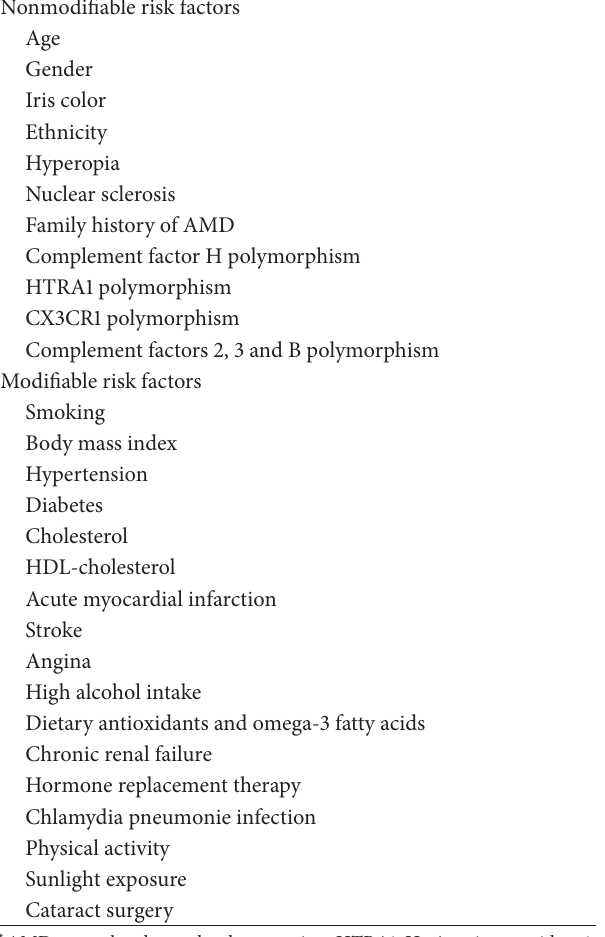
Table 1: Summary of the nonmodifiable and the modifiable risk factors for age-related macular degeneration ∗